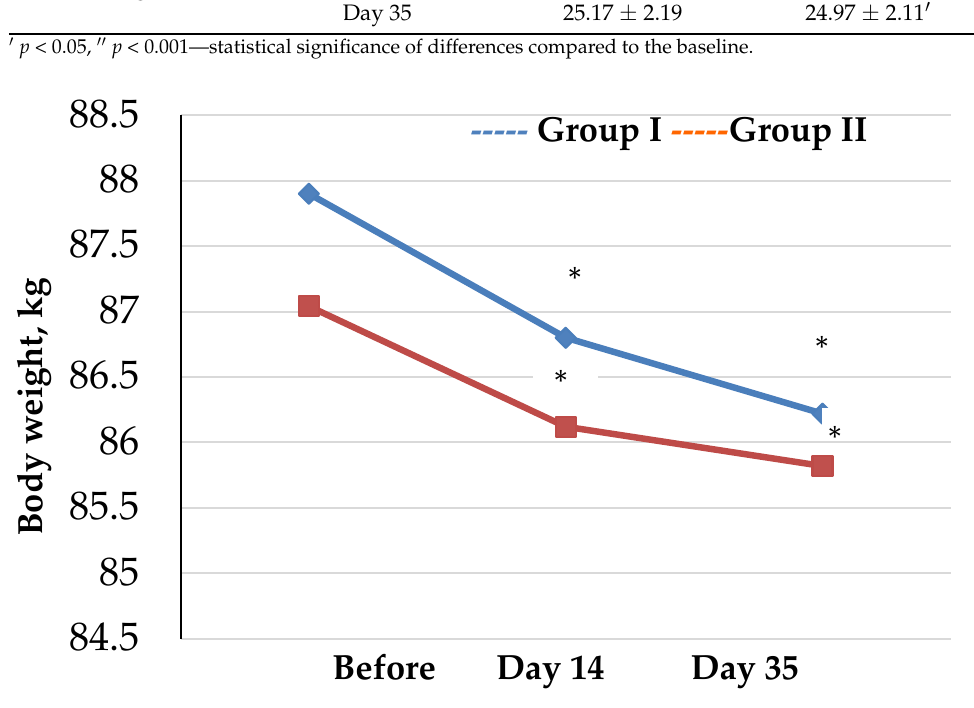
Figure 1. Trends in body weight values of athletes by group (* p < 0.05—statistical significance of differences within each group compared to the baseline).